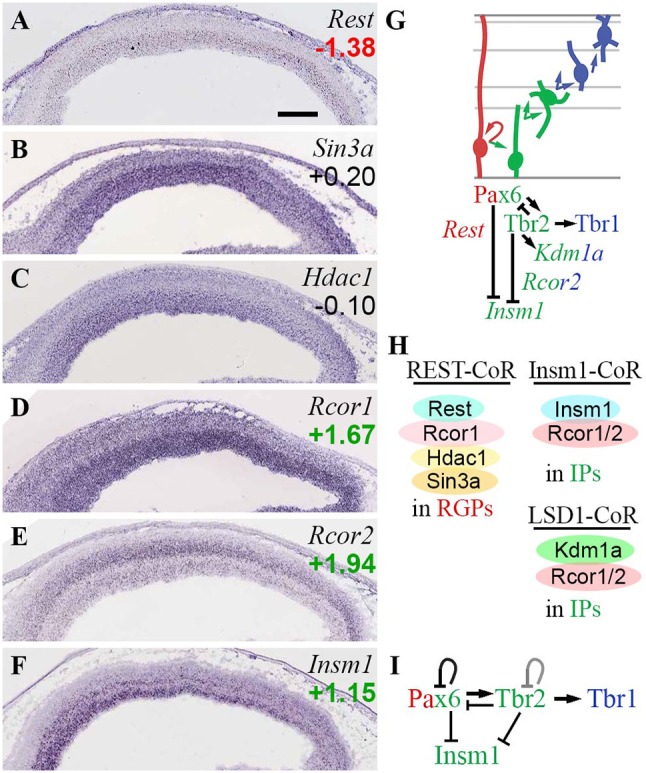
Rest and CoRest complexes. (A–F) Expression of indicated genes. While Rest
(A) was specifically expressed in RGPs, CoRest genes Rcor1
(D) and Rcor2
(E) were enriched in IPs, as was Insm1
(F). ISH: Genepaint. Scale bar: 100 μm. (G) Summary of gene expression and regulation. Interestingly, Tbr2 activated Kdm1a (Lsd1) but repressed Insm1; both are CoRest (Rcor1/2) binding partners. Pax6 also repressed Insm1. (H) Rest/CoRest complexes form in RGPs, while Insm1/CoRest and Lsd1/CoRest complexes form primarily in IPs. (I) Repression of Insm1 by the Pax6→ Tbr2→ Tbr1 cascade. Like Pax6 and Tbr2, Insm1 is a key regulator of IPs (Farkas et al., 2008). The Tbr2 loop is shown in gray to reflect unknown effect of Tbr2 on its own transcription.